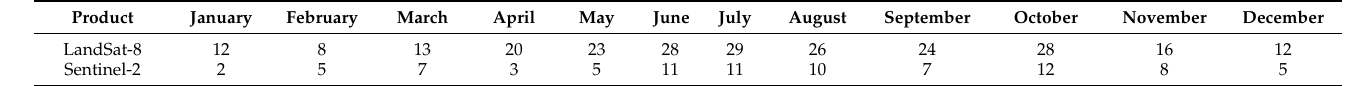
Table 2. Temporal distribution of number of used images from LandSat-8 and Sentinel-2